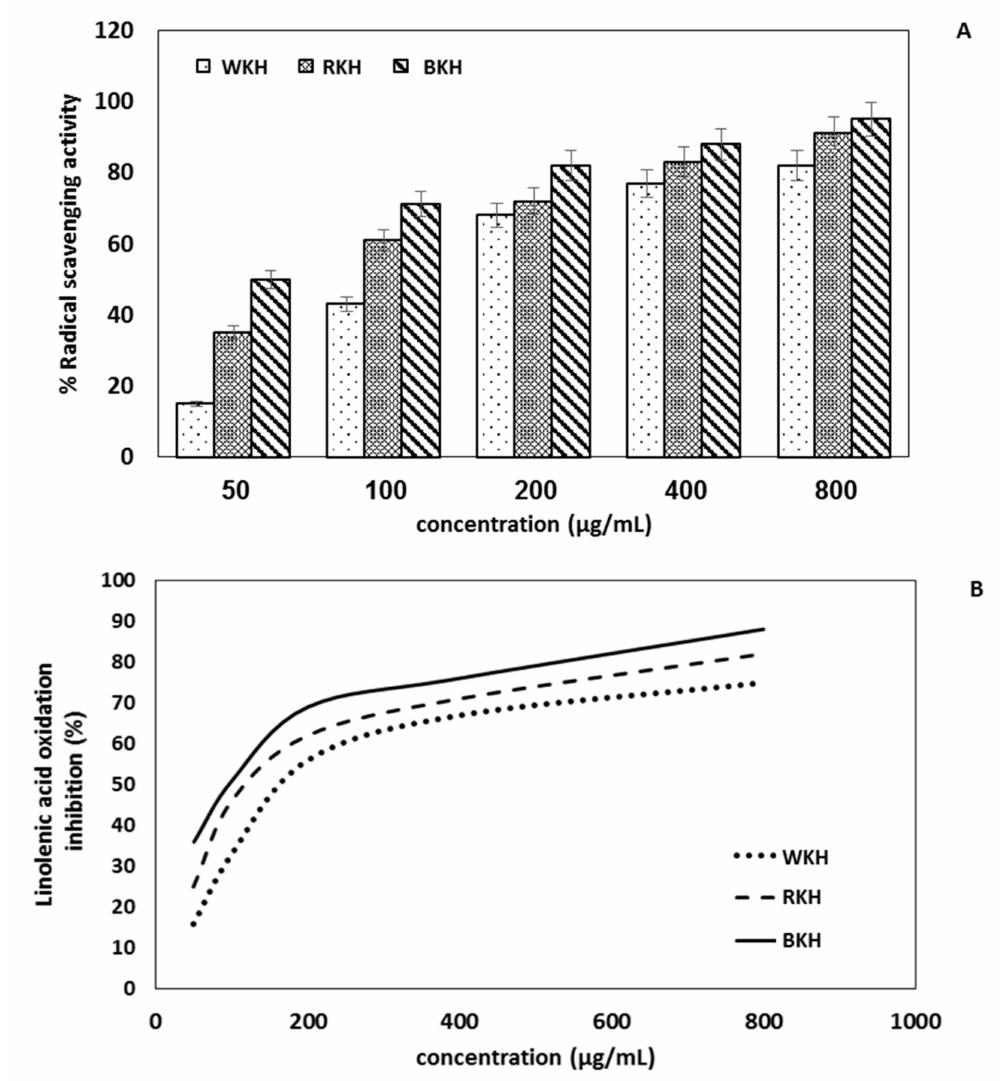
Figure 3. Free radical scavenging activity ( A ) and antioxidant activity ( B ) of protein Alcalase hydrolysates of black, red and white kidney bean protein (BKH, RKH, WKH). Protein Alcalase hydrolysis was conducted at 37 ◦ C, pH 6 for 30 min. Means with different lowercase letters indicate significant differences at p ≤ 0.05 by LSD. Table 4. Antibacterial activity against gram-positive and gram-negative bacterial strains (expressed as the diameter of the inhibition zones) of different concentrations (50–800 µ g/mL) of black, red and white kidney bean protein hydrolysate (BKH, RKH and WKH) obtained after 30 min Alcalase hydrolysis at 37 ◦ C.